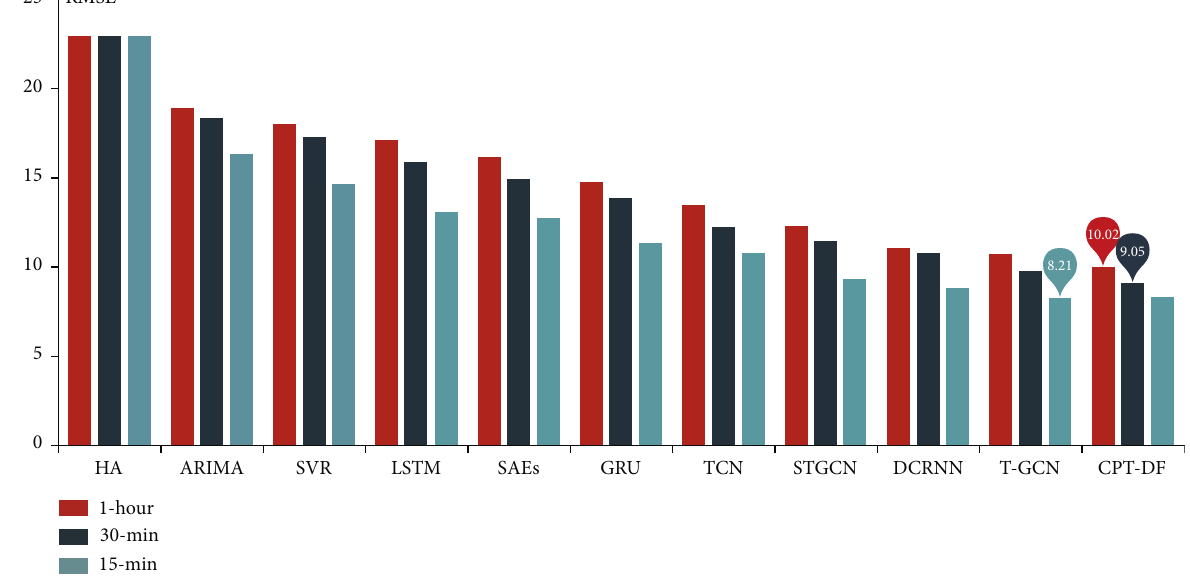
Figure 11: Visualization of prediction performance (RMSE) of di ff erent models at di ff erent time